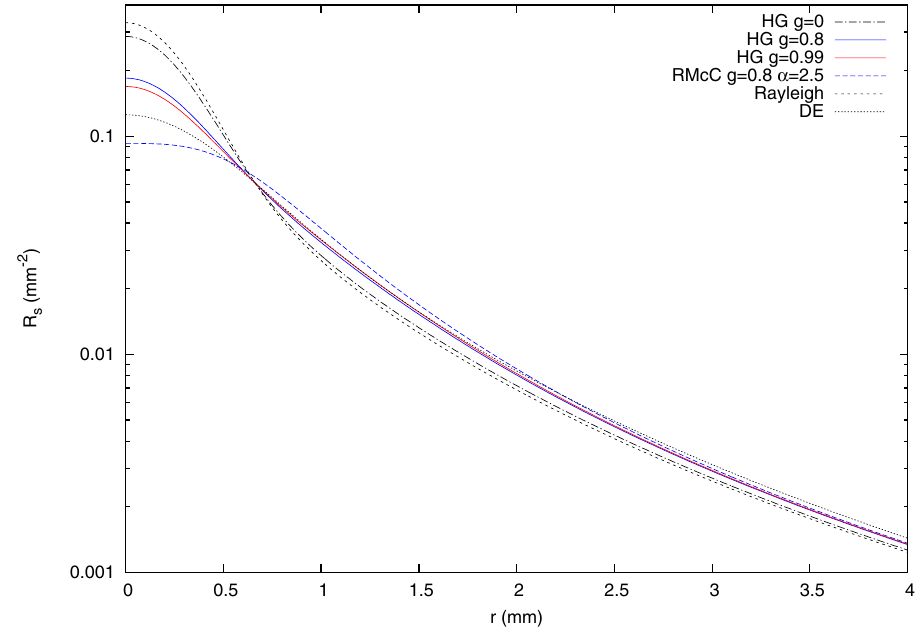
Figure 6. Steady-state spatially resolved reflectance from the three-layered scattering medium using the P 9 approximation with different phase functions.